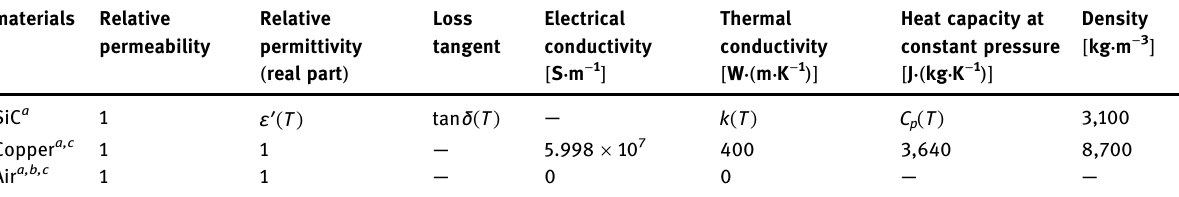
Table 1: Material parameters in the model materials